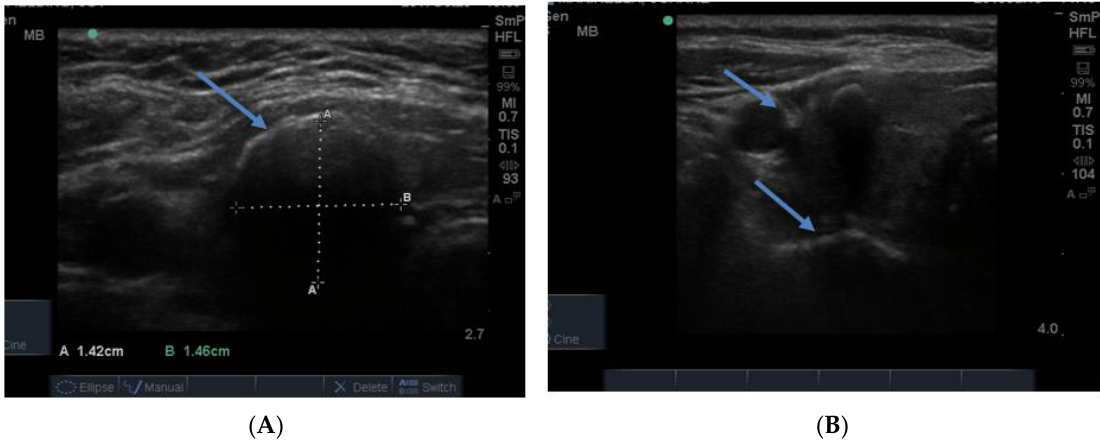
Figure 8. In ( A ) linear calcification in the anterior aspect of a benign 15 mm nodule is seen as a curved bright hypoechoic shelf (arrow) that blocks the transmission of the ultrasound waves, so the nodule behind appears to be very hypoechoic, as in a cyst. In ( B ) is seen a small hypoechoic calcified nodule (upper arrow) and below it, a larger nodule with linear calcification in its anterior surface (lower arrow).